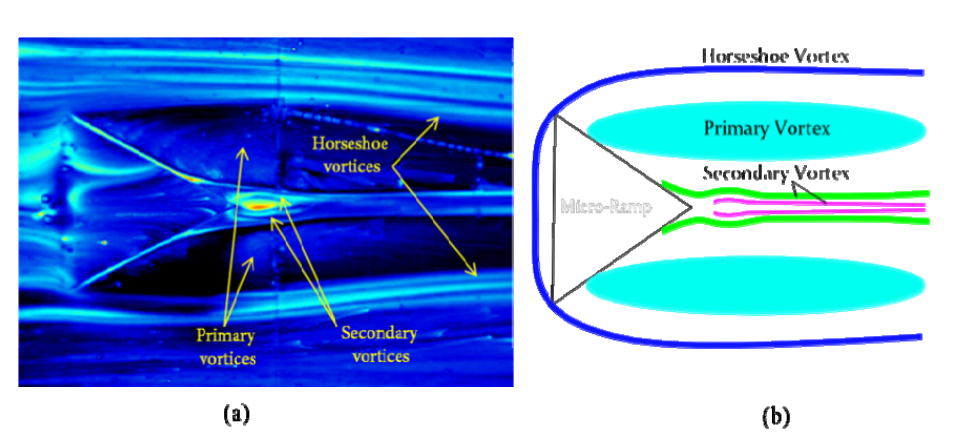
Figure 13. Surface flow visualization image after processing and the generation of schematic representation of the